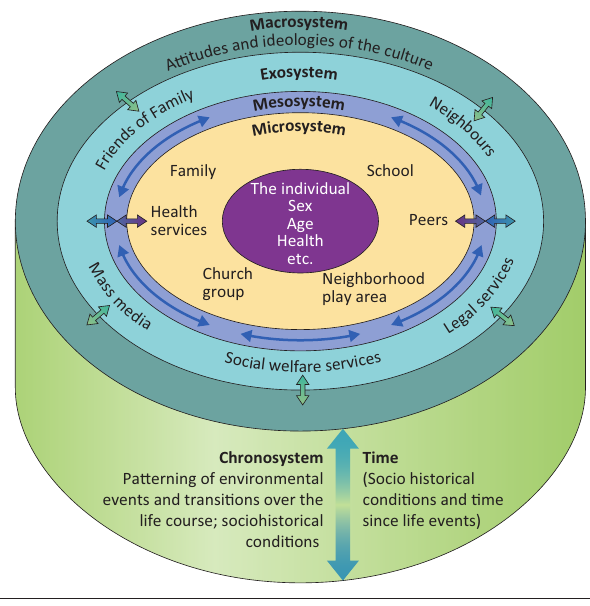
FIGURE 1: Bronfenbrenner’s ecological systems